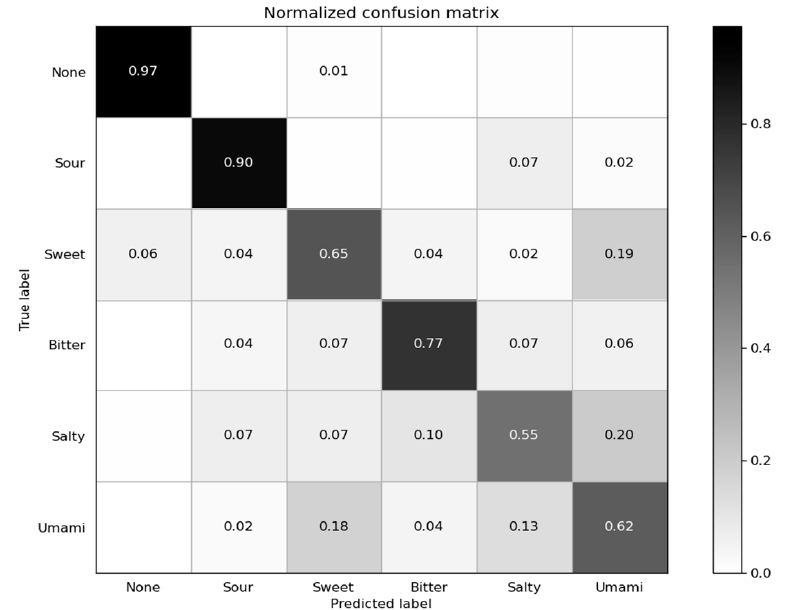
Figure 6. Confusion matrix on Dataset 01. Number in row i, column j is the ratio of N ij (number of samples classified as label j with true label i) to N i (number of samples with true label i), and values smaller than 0.01 are ignored.